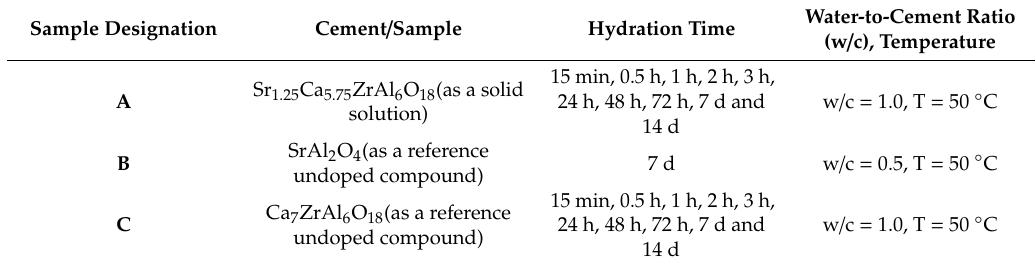
Table 1. Cement paste formulations, curing conditions and details of sample